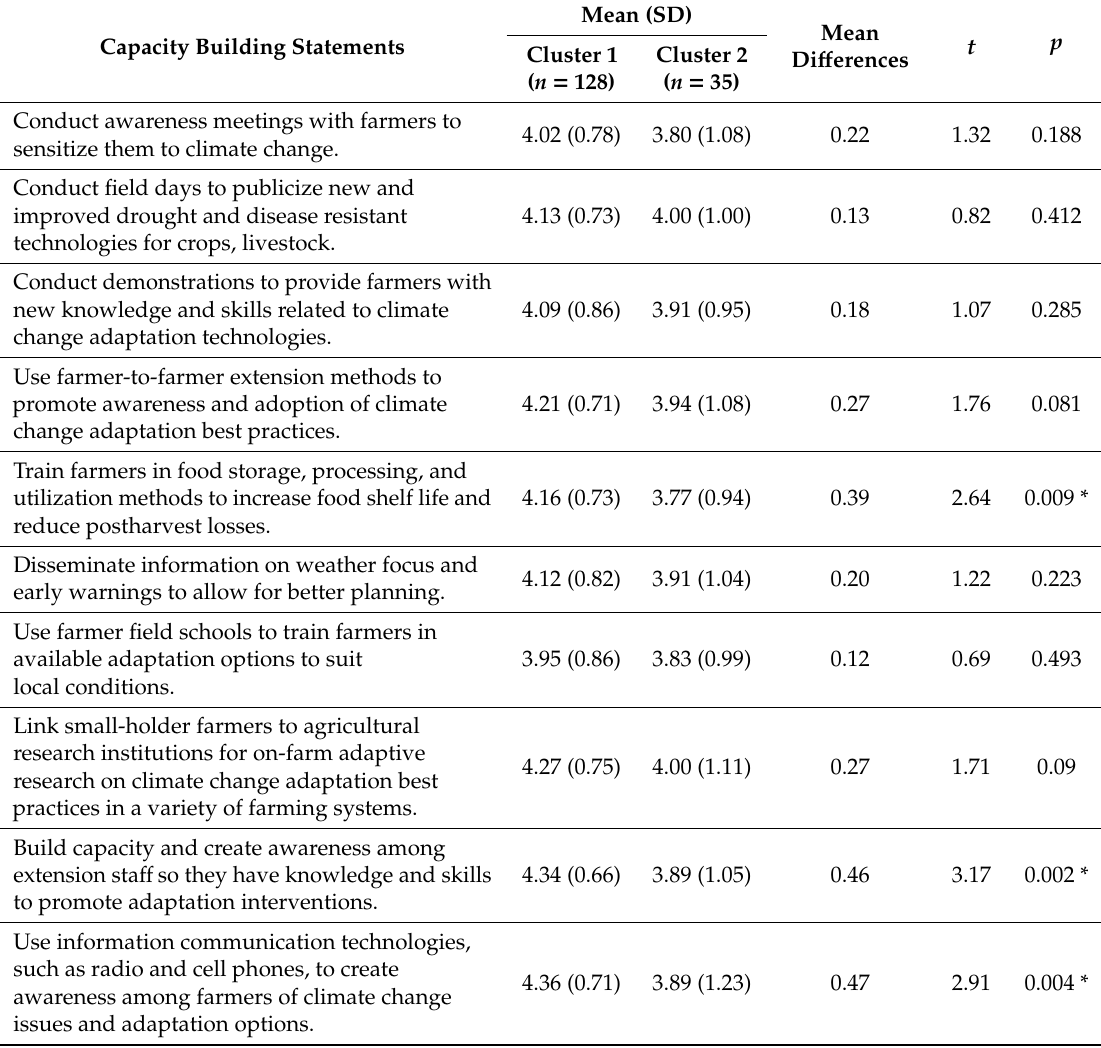
Table 8. Di ff erences between clusters of farmers according to their perceptions of the role of extension services in building